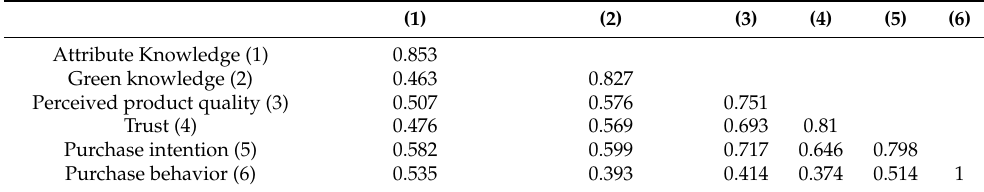
Table 5. Discriminant validity (FORNELL).